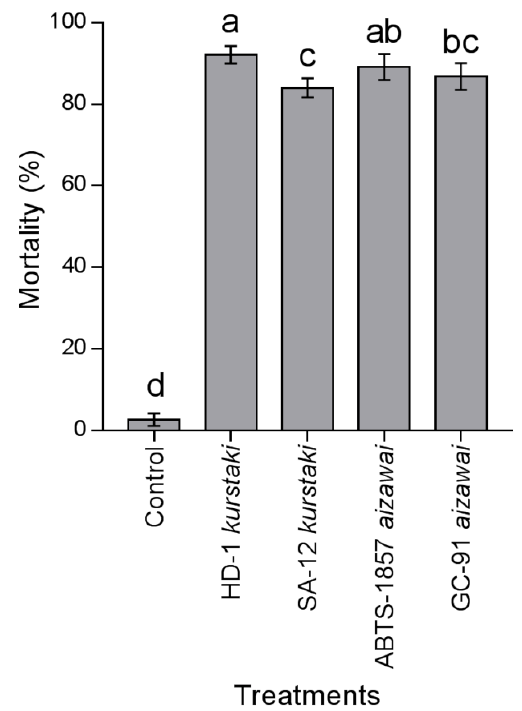
Figure 3. Mortality of Euprosterna elaeasa caterpillars by Bacillus thuringiensis strains to level LC 90 application on oil palm trees. Treatment means (percent mortality ± SEM) with different letters show significant differences by Tukey’s HSD test at the p < 0 . 05 level.